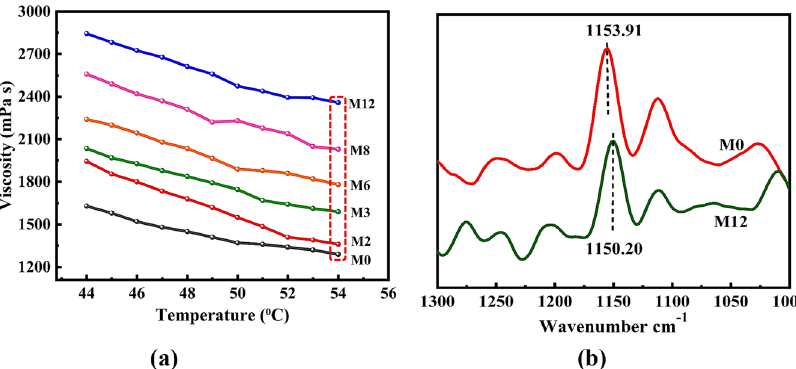
Fig. 1 Casting solutions characterizations. Viscosity curves of PSF/EVOH (20 wt. %) casting solution with increasing HNT content and temperature ( a ), Raman spectra of PSF/EVOH (M0) and PSF/EVOH /HNT (M12) casting solutions ( b Fig. 3a – c no changes in the dispersion and stability of the samples were observed, and the solutions of the respective samples were both stable and homogenously blended even after storing for 4 weeks and reheating. This suggests that the dispersion and interfacial bonding of the HNTs with the polymer solution are suf fi cient. Furthermore, a visual inspection of the PSF/EVOH because the intensity of the color increased with the loading concentration 28 .